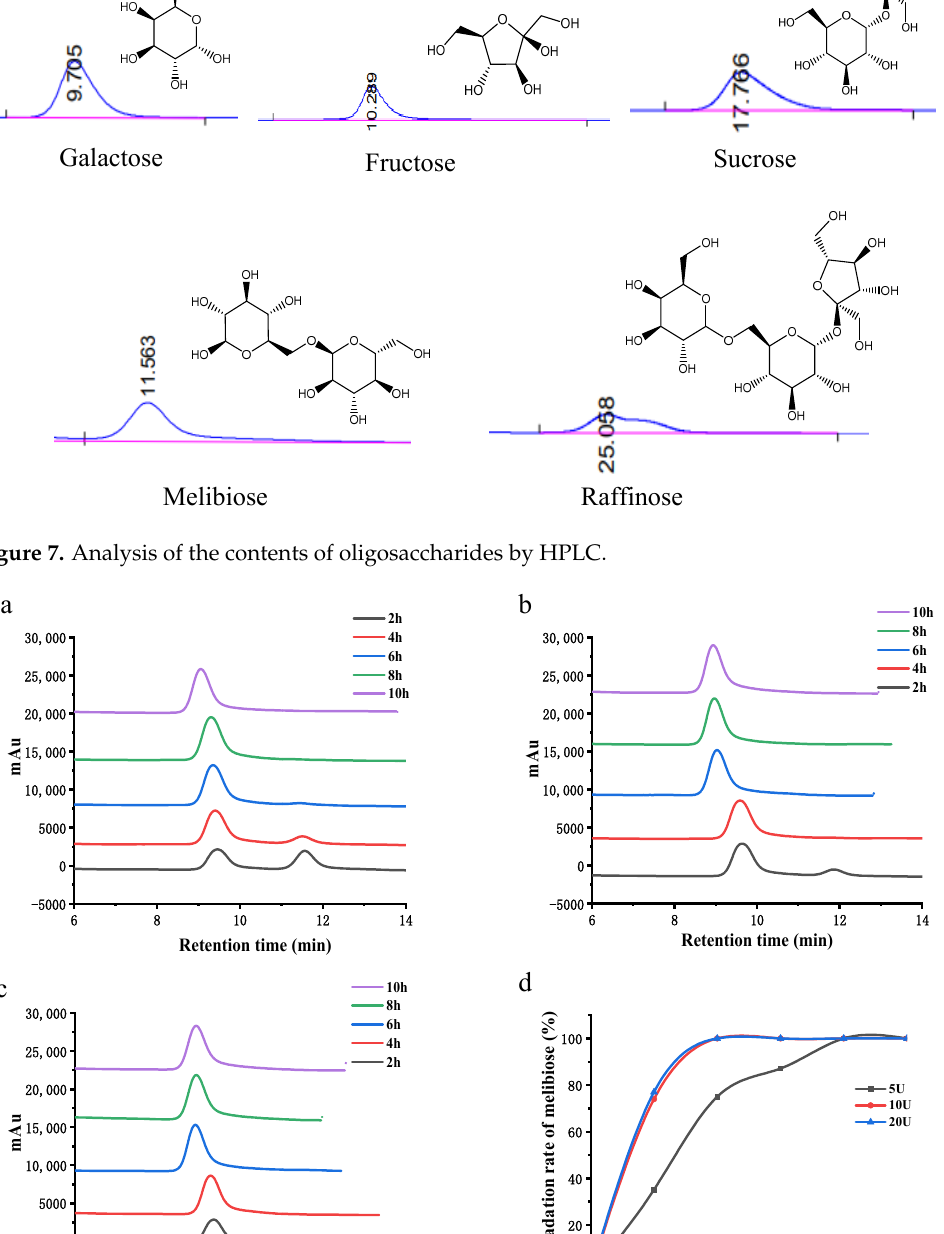
Figure 9. Analysis of the hydrolysis of raffinose by HPLC. ( a ) Enzyme dosage was 5 U/mL; ( b ) en- zyme dosage was 10 U/mL; ( c ) enzyme dosage was 20 U/mL. ( d ) The degradation rate of raffinose.